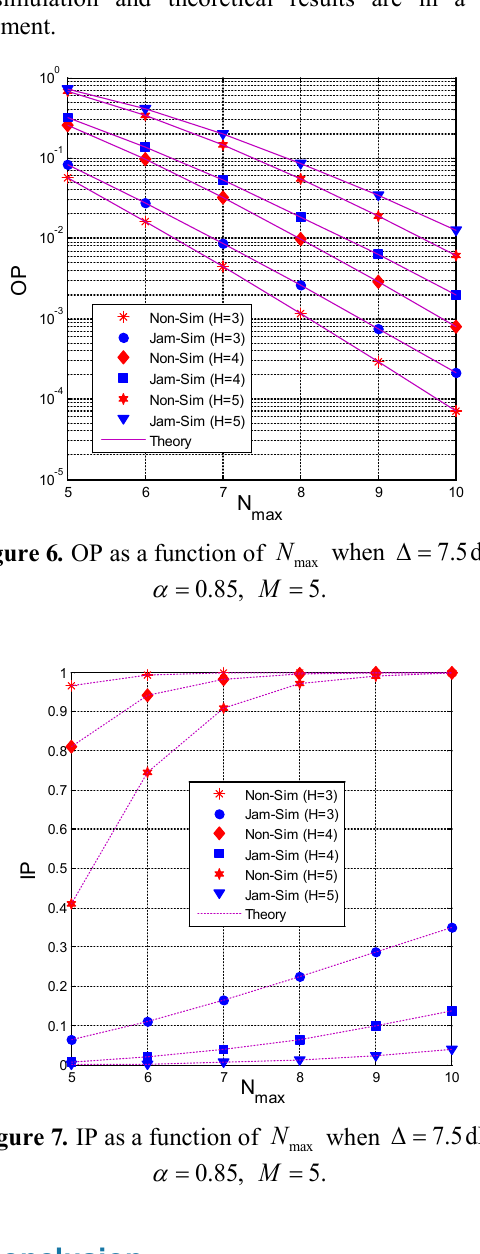
Figure 7 . IP as a function of